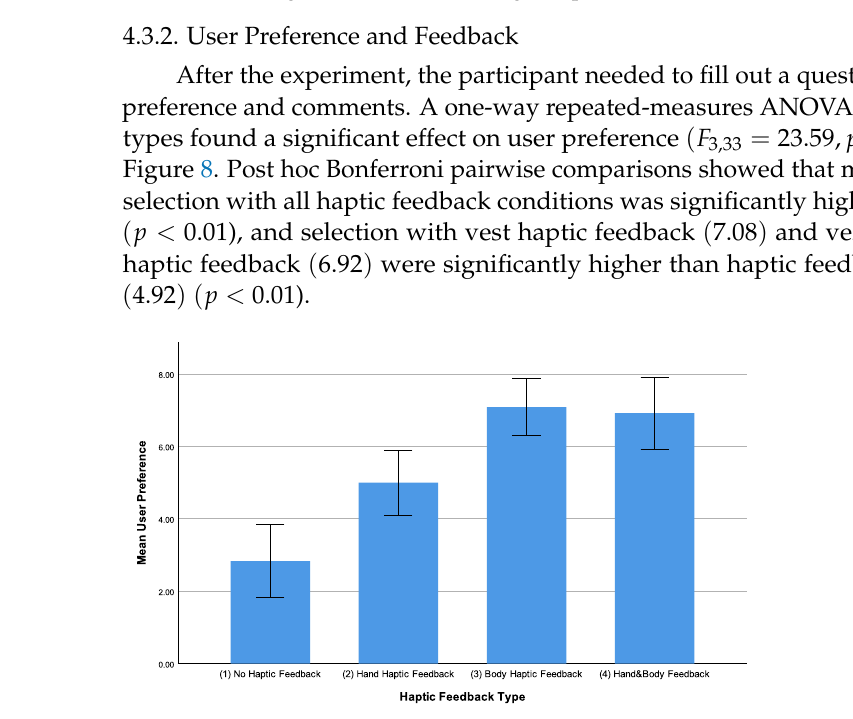
Figure 7. Mean selection time, error rate, hand movement distance, head movement distance, head rotation degree, and head target distance in the depth dimension of Study 2. ( a ) Mean selection time; ( b ) Mean error rate; ( c ) Mean hand movement distance; ( d ) Mean head movement distance; ( e ) Mean head rotation degree; ( f ) Mean head target depth distance.